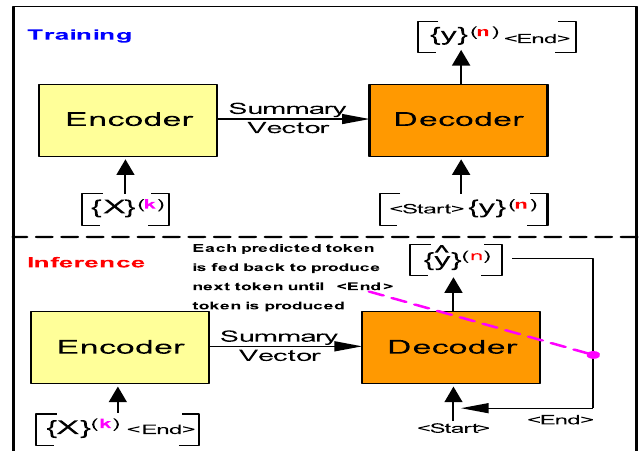
Figure 7. Model Under Training Vs. Inference. Encoder-Decoder Model are trained together using teacher forcing—decoder input is replaced with ground truth tokens which results in exposure bias. During inference previous decoder output is fed forward as input to output next token.